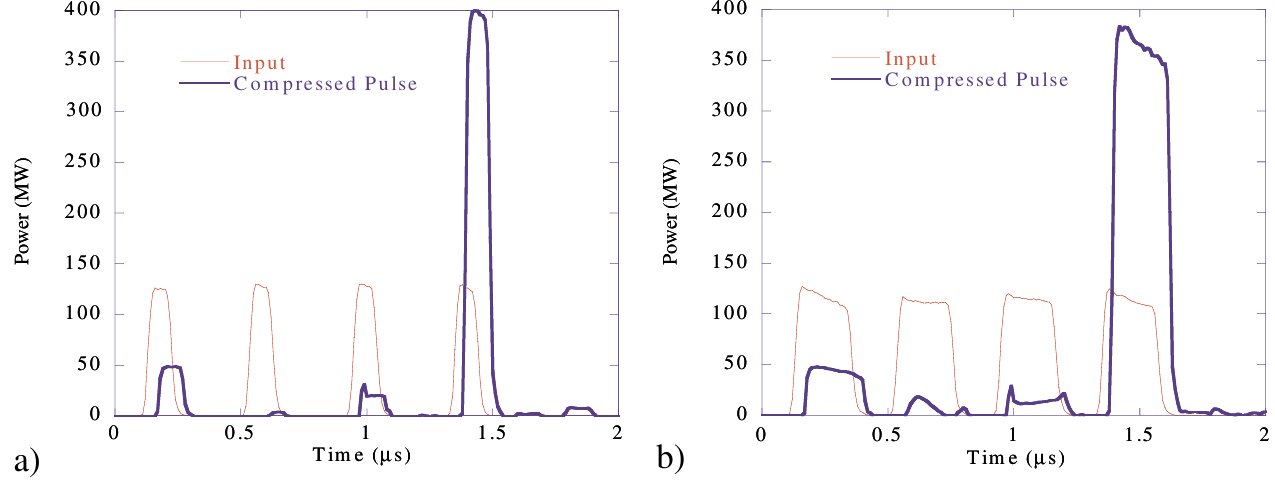
FIG. 22. (Color) Typical processing